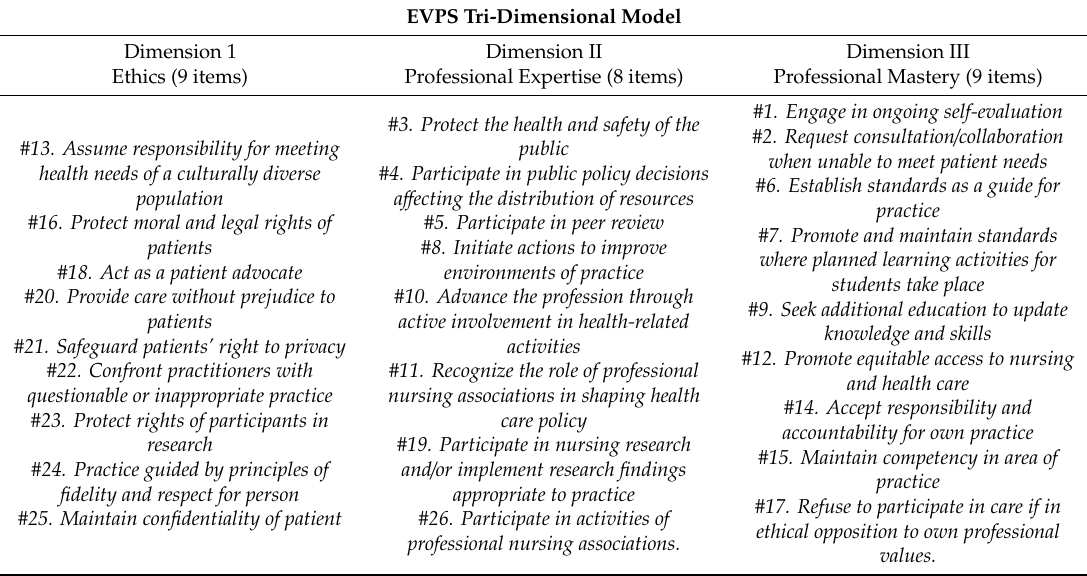
Table 1. EVPS tri-dimensional